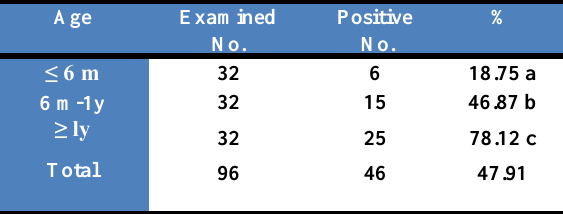
Table, 1: Real time-PCR positive cases of Babesia bovis according to age.